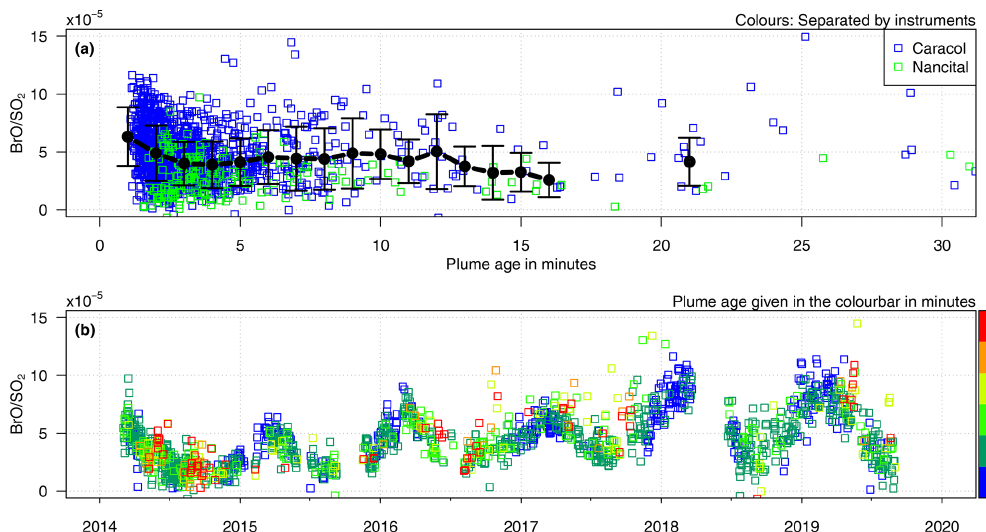
Figure 13. BrO / SO 2 molar ratios in the gas plume of Masaya depending on the plume age. The wind data imply for some data that the plumes did not transact the scan planes; these data are excluded from the plot. (a) The black dots refer to the averages of the respective 1min bins. (b) The red-coloured data span a plume age between 10 and